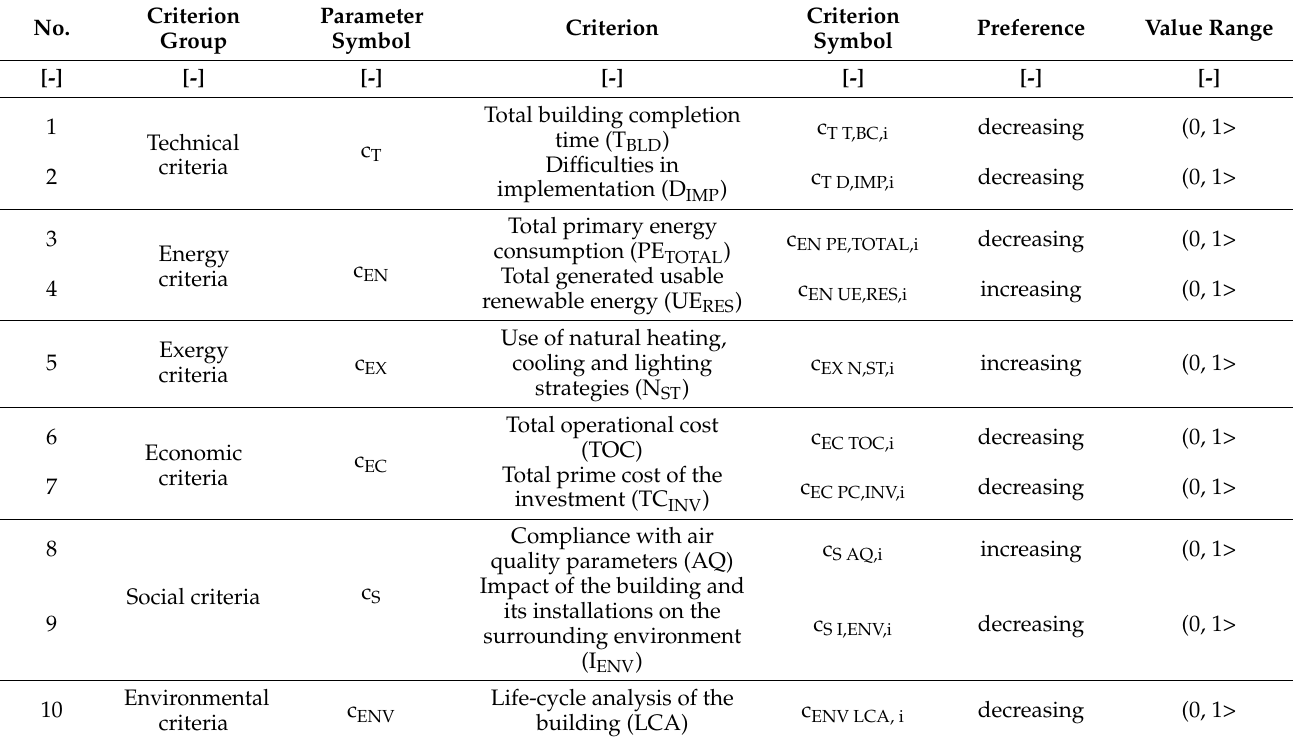
Table 1. Set of selected decision